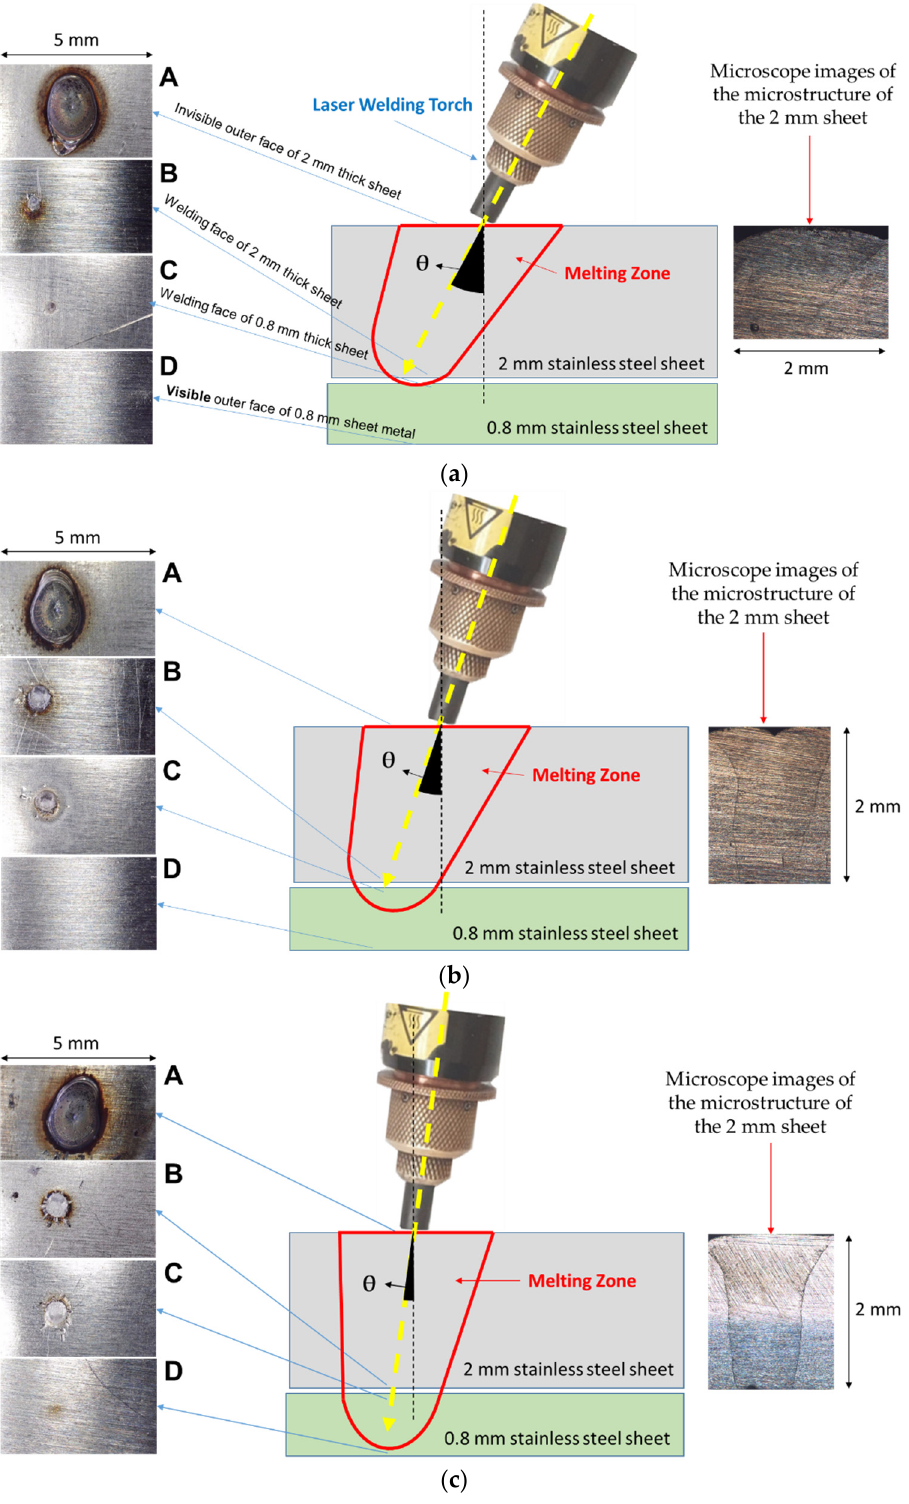
Figure 4. Weld traces and weld sections for different welding torch angles (70.43 Joules). ( a ) θ = 30° (extremely tilted holding angle). ( b ) θ = 15° (appropriate holding angle). ( c ) θ = 5° (extremely steep holding angle).